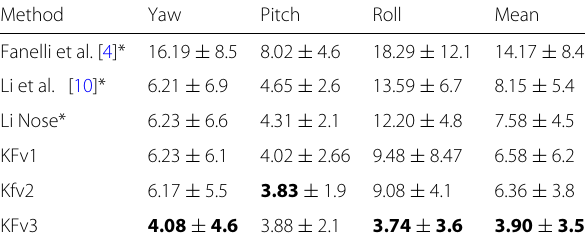
We collect the sequences with a Microsoft Kinect v1 under controlled conditions with a resolution of 640 × 480.